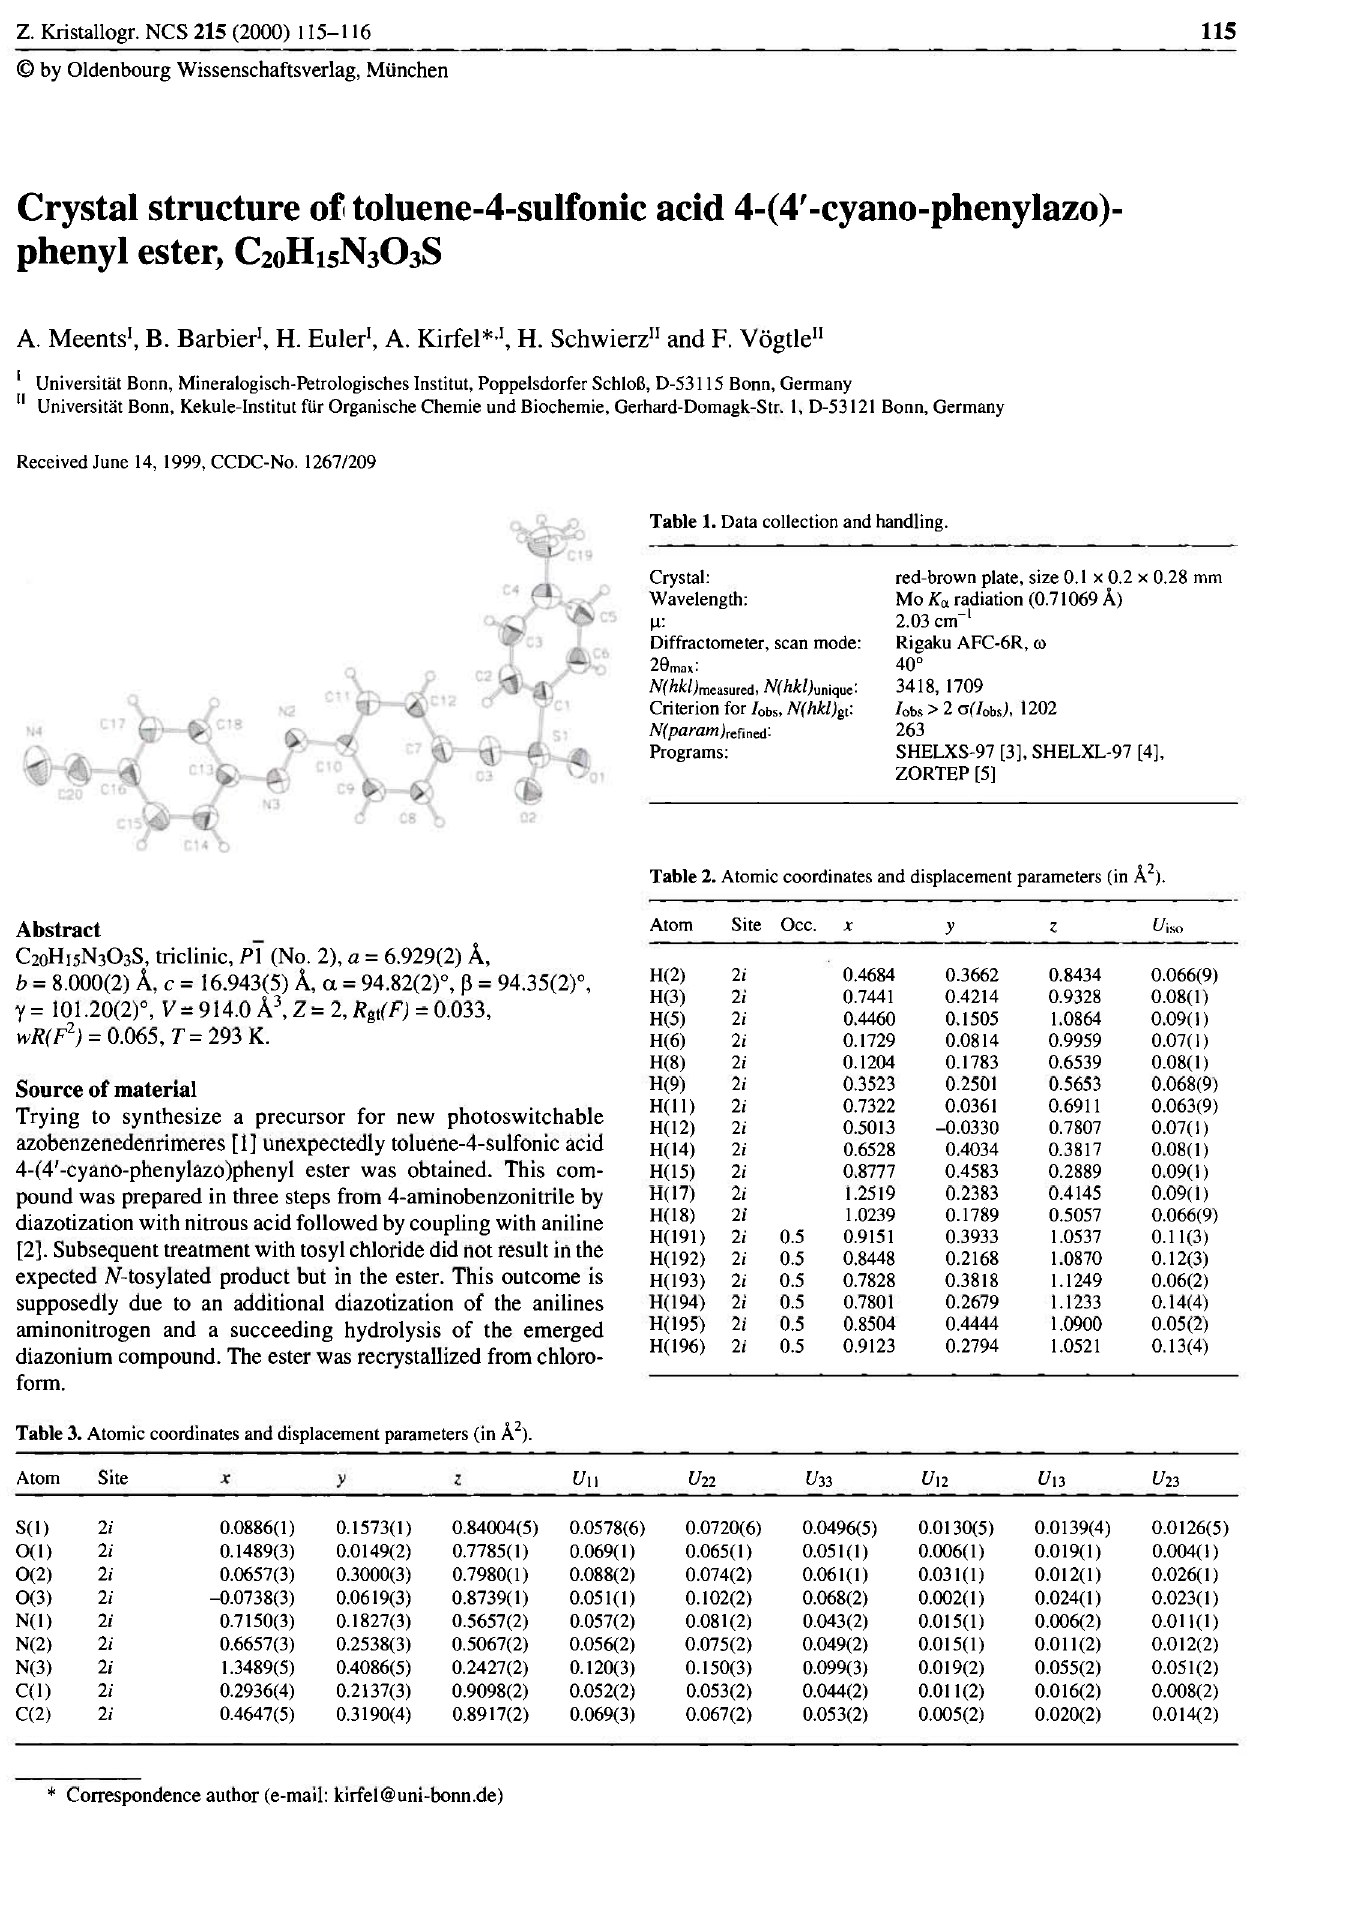
Table 1. Data collection and handling.